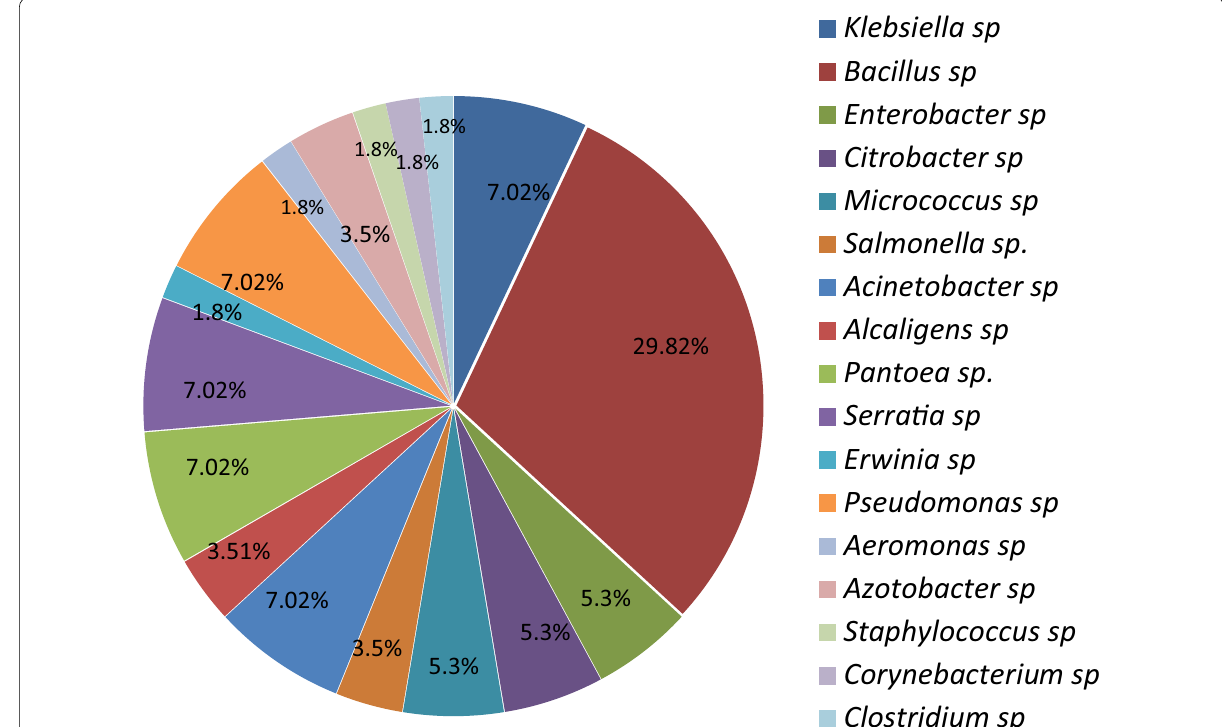
Fig. 1 Percentage occurrences of bacteria isolated from termite mound soil